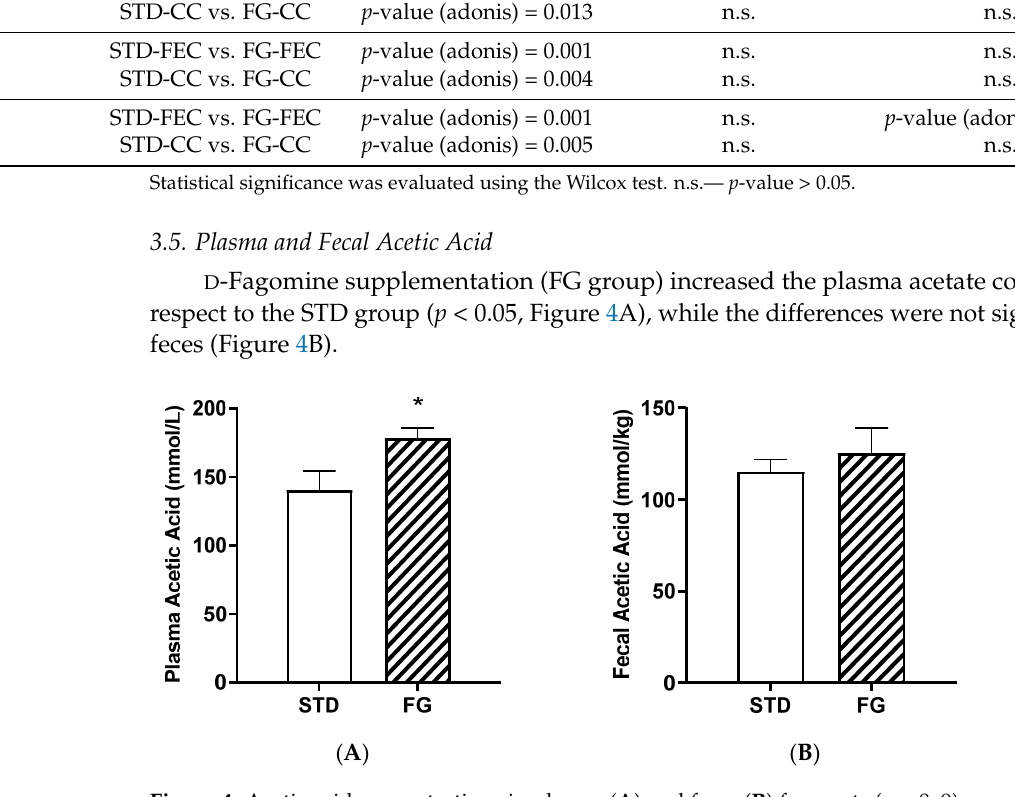
Plasma LTB4 and IL ‐ 6 were significantly ( p < 0.05) lower in animals after 6 months of Plasma LTB4 and IL-6 were significantly ( p < 0.05) lower in animals after 6 months of supplementation with D -fagomine with respect to those not supplemented (Figure